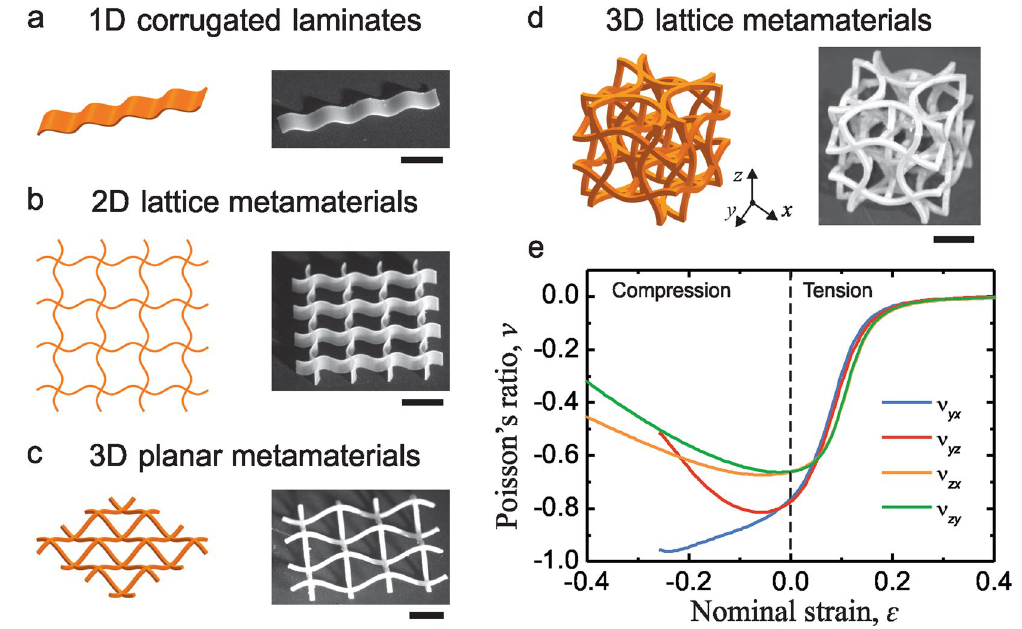
Figure 6. The system of lattice metamaterials with curved beams. ( a ) 1D corrugated beam; ( b ) 2D lattice metamaterial; ( c ) 3D planar metamaterial; ( d ) 3D lattice metamaterial. ( e ) The Poisson’s ratio as a function of nominal strain for the 3D lattice metamaterials under uniaxial compression and tension by FEM analysis. Because of the symmetry of the structures in x and y directions, we only show the results of loading in y and z directions. Scale bar: 1